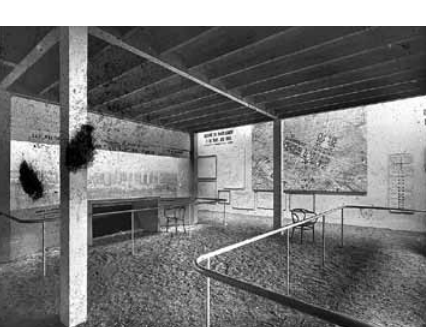
fig. 12. General floor plan of “Plan Voisin”. Version published in Science et Industrie 1926, p. 30. © flC-aDaGP